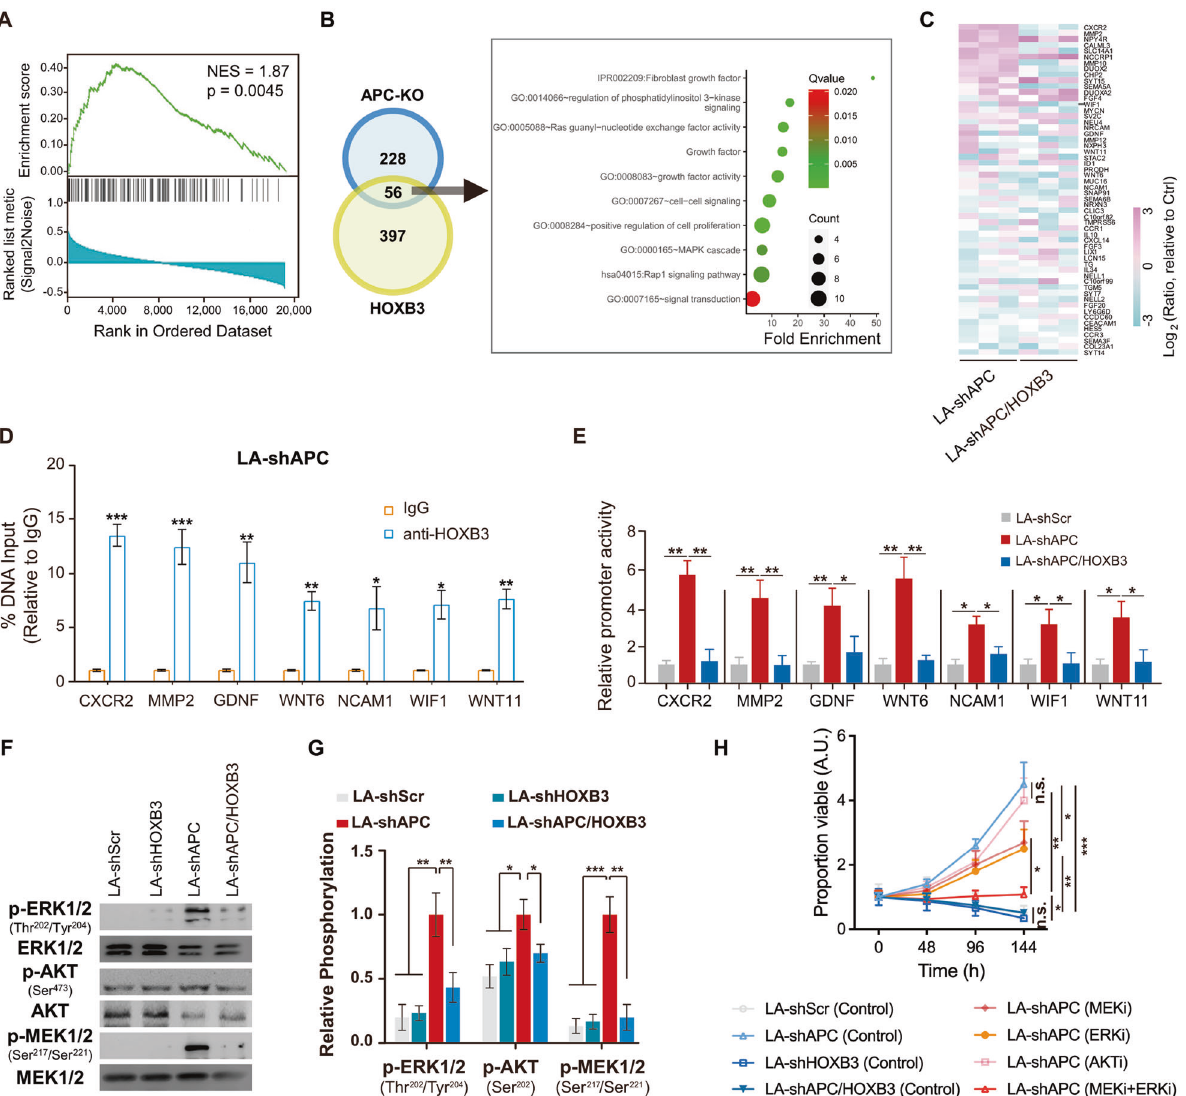
Fig. 6 HOXB3 transcriptionally drives multiple WNT-regulated genes and is required for abiraterone resistance in APC-de fi cient CRPC cells, see also Fig. S4. A GSEA of the APC-KO associated genes in data set of GSE144325 comparing differentially expressed genes in HOXB3 high HOXB3 negative tumors. Normalized enrichment score (NES) = 1.87, p = 0.0045. B Venn diagram showing genes signi fi cantly up- regulated in HOXB3 high and APC-KO samples. Overlapped genes showing signi fi cant enrichments in cell proliferation determined by Functional Annotation Tool [32], including RAS, PI3K-AKT and MAPK signals (See also Tables S3, S4). C LNCaP-AI cells were stably infected by shScramble (short for LA-shScr), shAPC (short for LA-shAPC), or by shAPC and shHOXB3 (short for LA-APC/HOXB3), followed by qRT-PCR assay for the overlapped genes in these cells. Heat maps showing the results of PCR that shAPC upregulated almost all the overlapped genes, while most of them overturned by additional HOXB3 knockdown. D qRT-PCRs assay based on CHIP experiments showing HOXB3 binds to the promoters of representative WNT-regulated genes. ChIP experiments using anti-HOXB3 antibody or normal IgG were performed in LA-shAPC cells. E The pGL3-CDCA3 was co-transfected with pcDNA3.1-HOXB3 or pcDNA3.1-vector into LA-shScr, LA-shAPC, and LA-APC/HOXB3 cells. Luciferase assays for promoter activities of representative WNT-regulated genes in indicated cells 24 h post transfection. F , G Western-blot and Bar graph showing upregulated phosphorylation on ERK1/2 (Ras signaling pathway), AKT (PI3K signaling pathway), and MEK1/2 (MAPK signaling pathway) by APC-knockdown in LNCaP-AI cells, which could be overturned by additional HOXB3-knockdown. H MTT assays in LNCaP-AI cells infected by shHOXB3, sh-APC or shHOXB3 + shAPC (shAPC/HOXB3). All of these cells were cultured in 10% CSS-FBS medium with abiraterone. And with or without speci fi c inhibitors of MEK1/2, ERK1/2, AKT1/2/3. Error bars indicate mean ± SD. * p < 0.05, ** p < 0.01, *** p < 0.001. HOXB3 and WNT signaling, molded a type of NHT-resistant CRPC, shows that HOXB3 is an independent risk factor of PSA and identi fi ed HOXB3 as a therapeutic target of WNT-ON CRPC. progression and death in mCRPC patients. To be speci fi c, HOXB3 serves as a downstream transcription factor of WNT WNT and prostate cancer progression and therapy-resistance pathway and de fi nes a subtype of CRPC with WNT activation that WNT signal is a general designation of canonical WNT signaling, resistant to antiandrogen. Finally, HOXB3 suppression reduces cell noncanonical WNT signaling, and WNT-dependent stabilization of proliferation in WNT-ON CRPC cells and sensitizes WNT-ON CRPC proteins (WNT-STOP), a novel transcription-independent branch of tumors to abiraterone. These results revealed a link between Cell Death and Disease (2023)